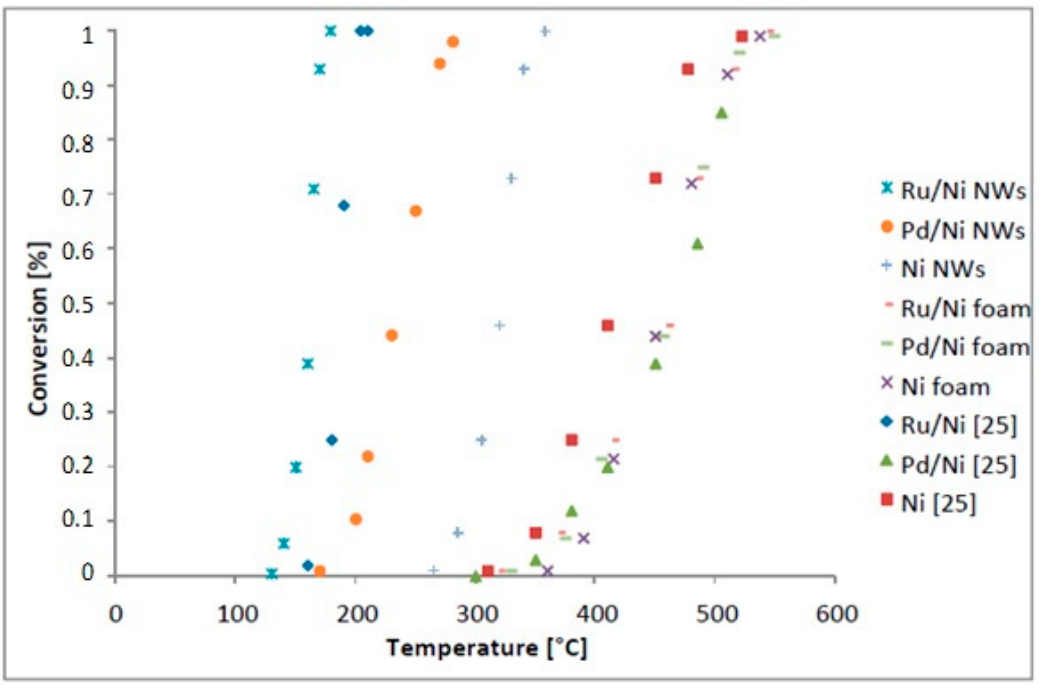
Table 3. CO 2 methanation on the Ru and Pd nanoparticles deposited on different nickel and silica carriers compared to the literature data.